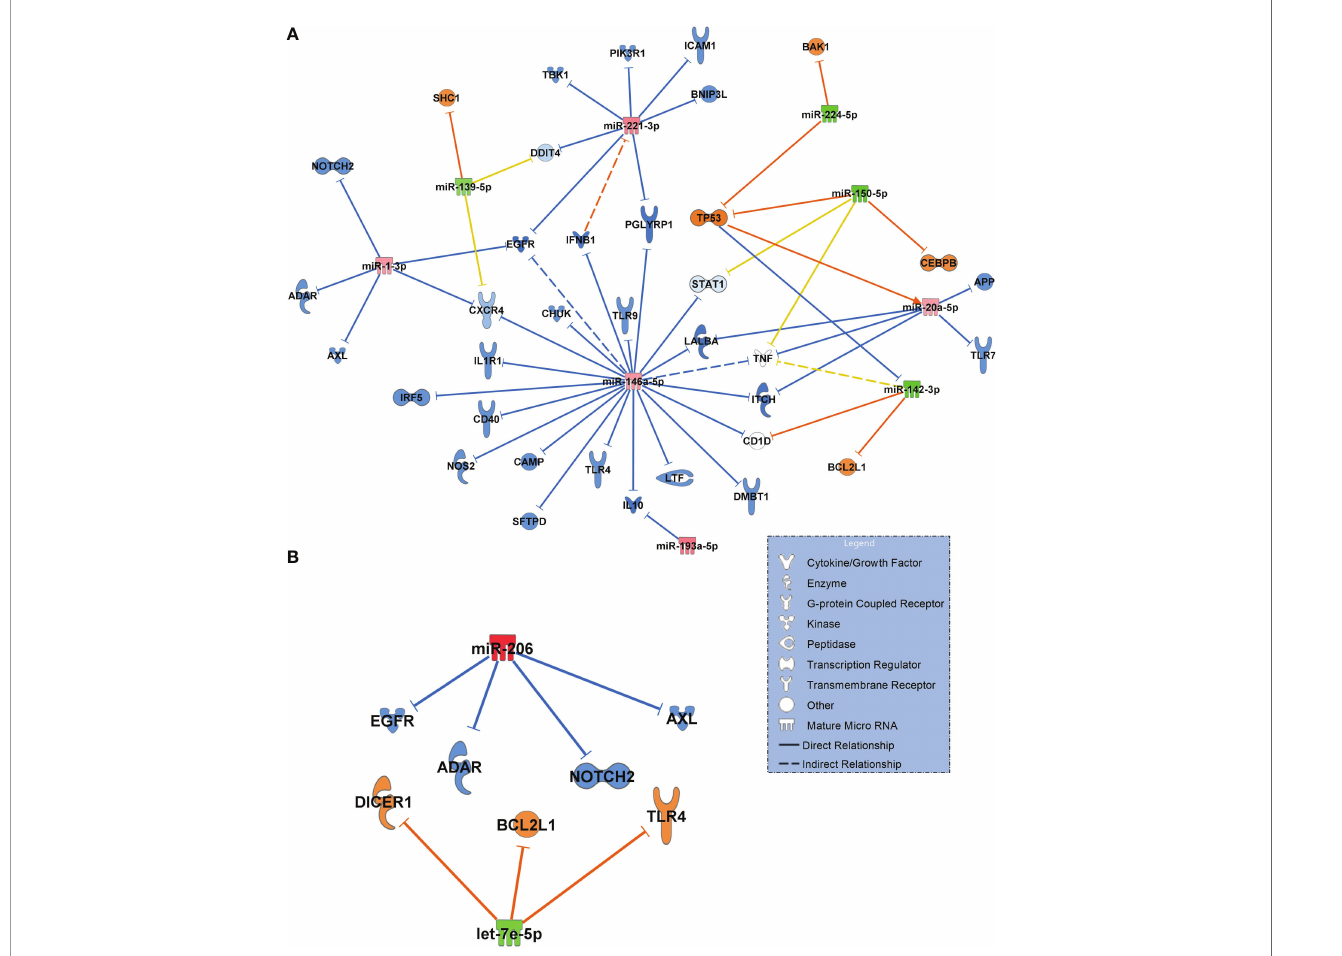
FIGURE 6 | (A) Signalling network generated from small RNA sequencing data of healthy controls (n=18, baseline) in comparison to patients with COVID-19 pneumonia (n=15). (B) Network COVID-19 pneumonia (n=15, baseline) vs. COVID-19 ARDS (n=15). For generation of the networks, data were fi ltered for antimicrobial response and lung as an organ system. Only experimentally con fi rmed relationships between miRNAs and their targets were included. Signi fi cantly upregulated miRNAs are shown in red and their predicted and presumably inhibited targets in blue. Downregulated miRNAs are shown in green, and their activated targets are depicted by orange colour. Yellow lines and non – coloured molecules indicate undetermined regulatory effects because the transcripts were targeted by miRNAs with different directions of regulation. Solid lines indicate direct and dashed lines indirect relationships. The legend inserted into the graph illustrates the type of target molecules according to the symbols used in the